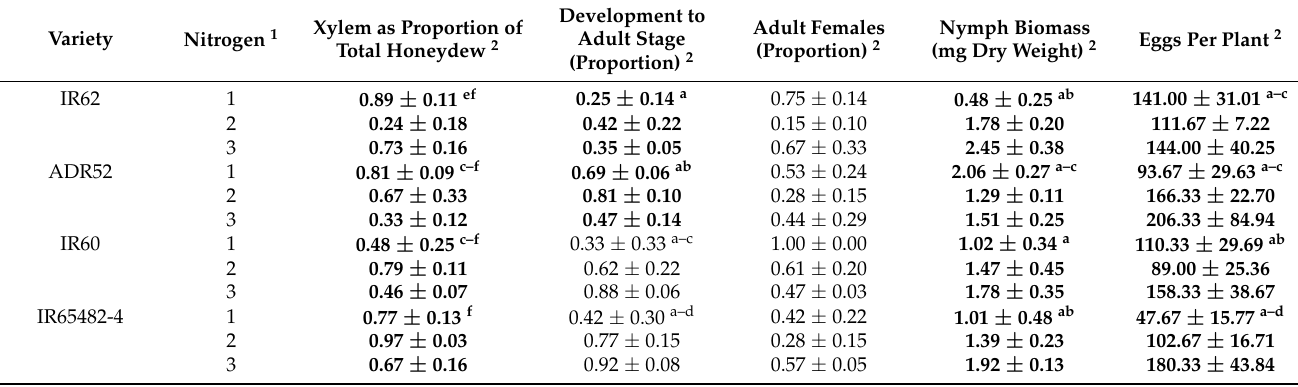
Table 1. Planthopper responses to rice lines under three nitrogen treatments (1 = zero added nitrogen, 2 = 80 Kg ha − 1 , 3 = 150 Kg ha − 1 ). Numbers are means ± SEM. Further details are presented in Table S1.